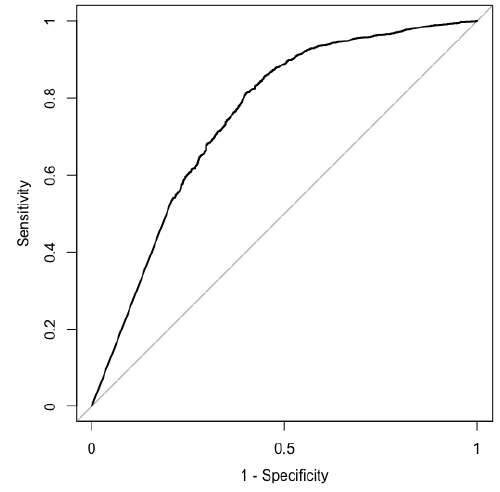
Figure 9. ROC curve for NN (ReLU). (AUC = 0.757, F-score = 0.727).